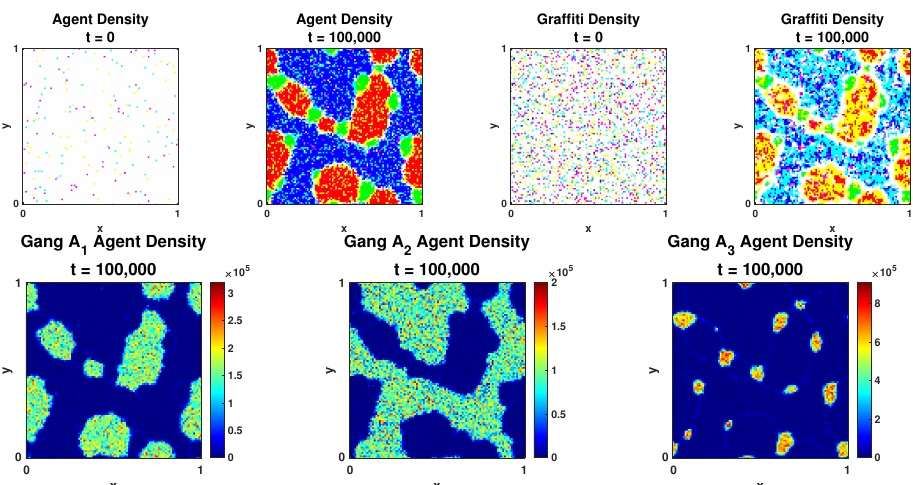
Figure 14. Top row : Temporal evolution of the agent and graffiti densities for the Threat Level Model. Here β 1 = 2 × 10 − 5 , β 2 = 3.5 × 10 − 5 and β 3 = 0.5 × 10 − 5 . We also have N 1 = N 2 = N 3 = 50,000, with λ = γ = 0.5, δ t = 1 and the lattice size is 100 × 100. It is clearly seen that the agents segregate over time. Bottom row : The agent and graffiti densities for gangs 1 (left), 2 (middle), and 3 (right) can be seen after 100,000 time